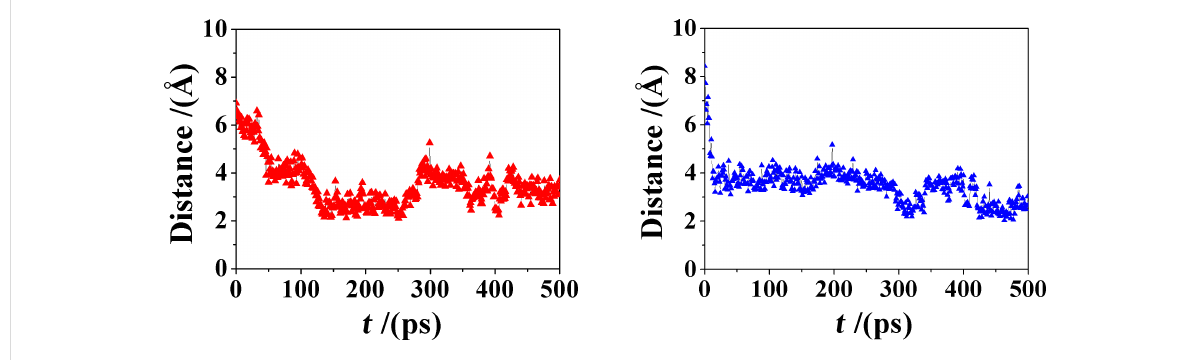
Figure 5: The distance between the center of mass (c.o.m.) of molecule 1 (at left) and of molecule 2 (at right) from the c.o.m. of the β -CD.